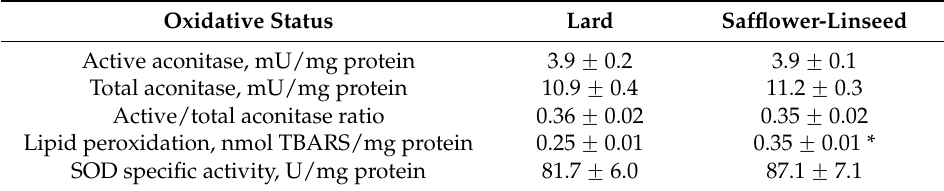
Table 5. Oxidative status in liver mitochondria from rats fed lard or safflower-linseed high fat